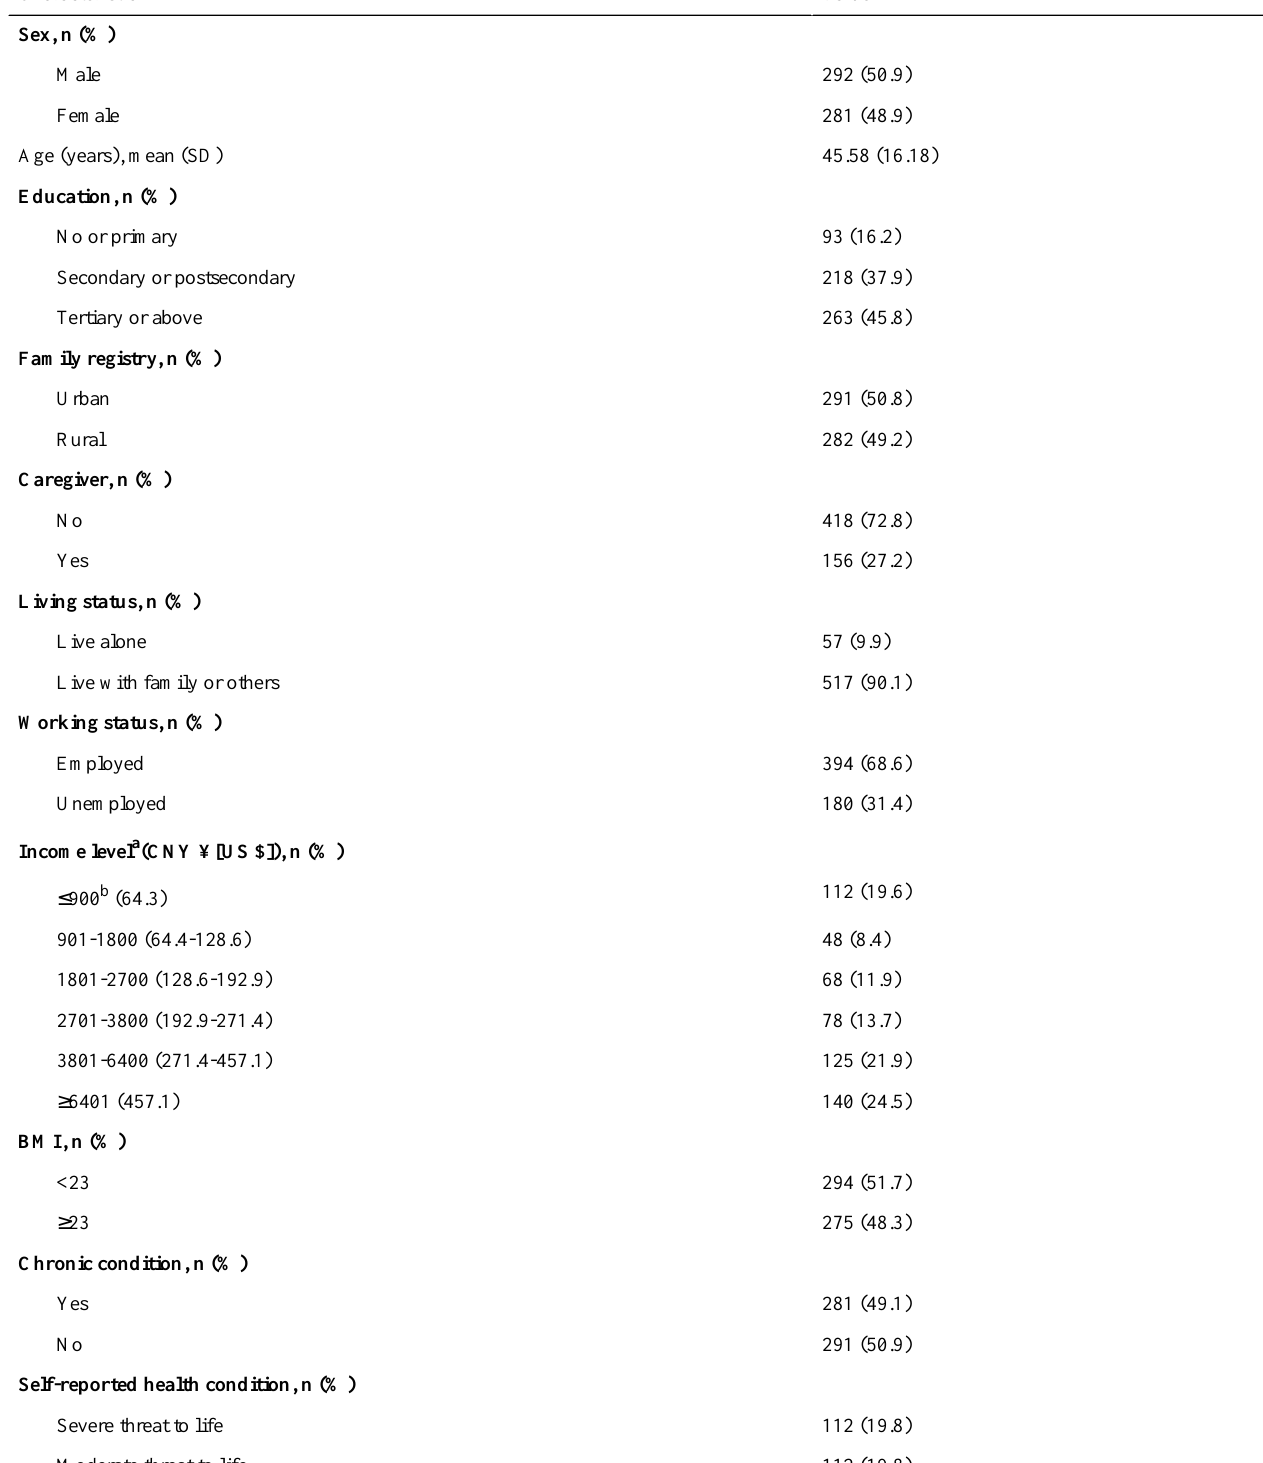
Table 1. Respondents’characteristics